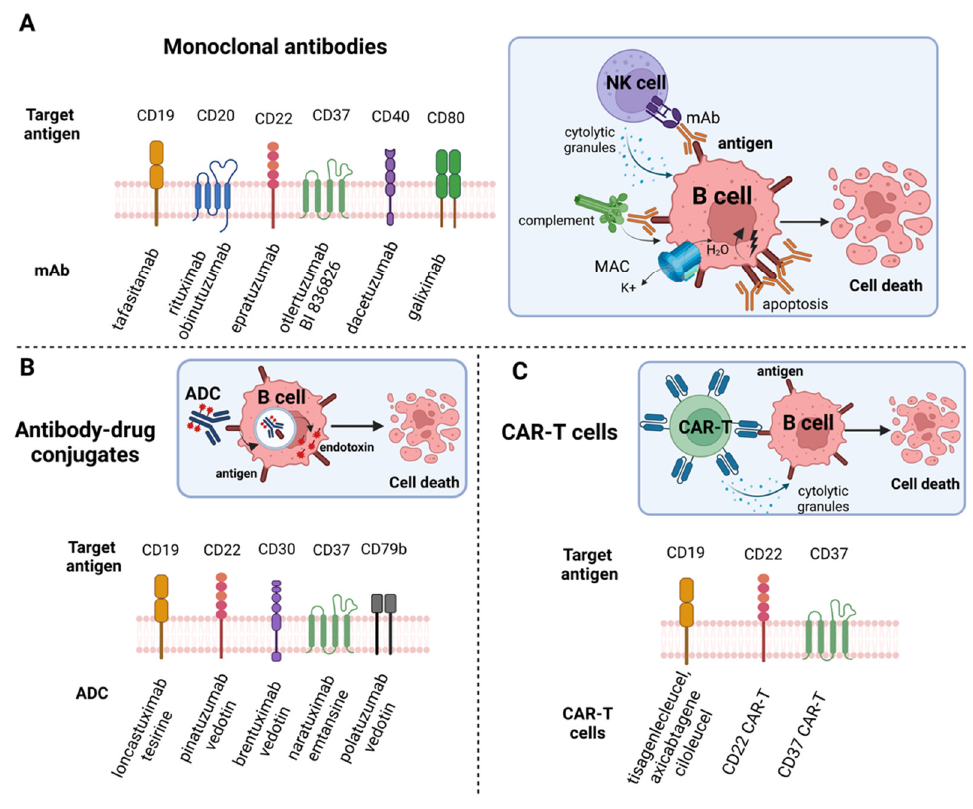
Figure 3. Targeted immunotherapies in DLBCL investigated on cellular models. ( A ) Monoclonal antibodies (mAbs); ( B ) Antibody-drug conjugates (ADCs); ( C ) chimeric antigen receptor T cells (CAR T-cells). Created with BioRender.com, accessed on 30 October 2022. Table 2. Overview of immunotherapeutic strategies and cell lines used in evaluation of their